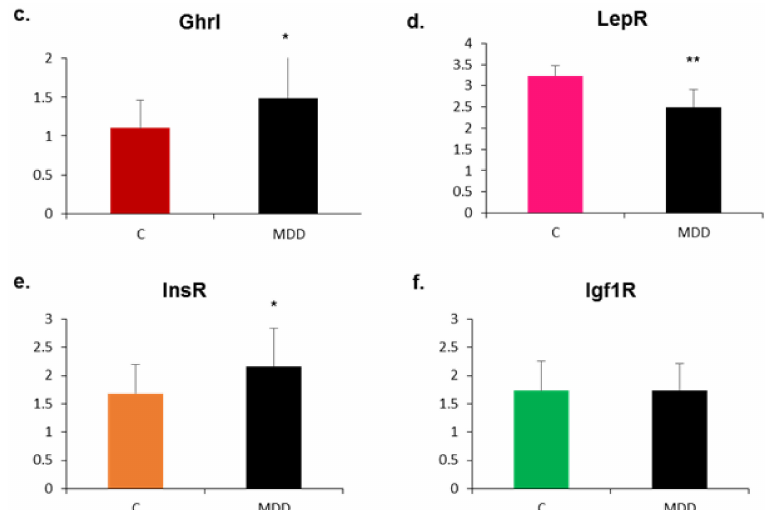
Figure 4. E ff ects of methyl donor deficiency on mRNA expression of neuropeptides and receptors in the hypothalamus of rat pups at 21 days of age. Data are means ± SD from 6 ≤ n ≤ 8 individuals and are reported in arbitrary units. Statistically significant di ff erences between control (C) and deficient (MDD) rats: * p < 0.05 and ** p < 0.01. ( a ) Neuropeptide Y (NPY); ( b ) pro-opiomelanocortin (POMC), ( c ) ghrelin